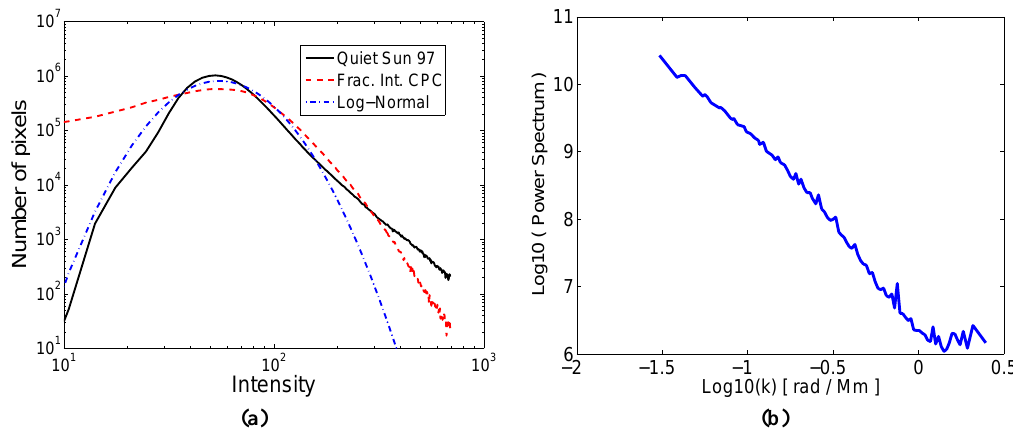
Fig. 2. (a) Histogram of original data set in log-log scale, together with a lognormal distribution having the same mean and variance, and the histogram of a set of 54 artificial images generated by a multiplicative cascade model. (b) Omnidirectional power spectrum. For Fourier wavenumbers 0 . 03 < || k || < 1 . 12rad/Mm, the spectrum exhibits a power law with index equal to − 2.8 (estimation using least